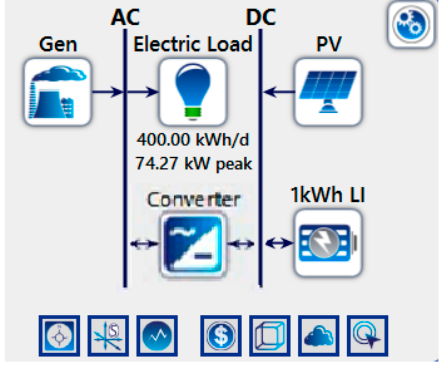
Figure 4. Proposed configuration of HPGP.